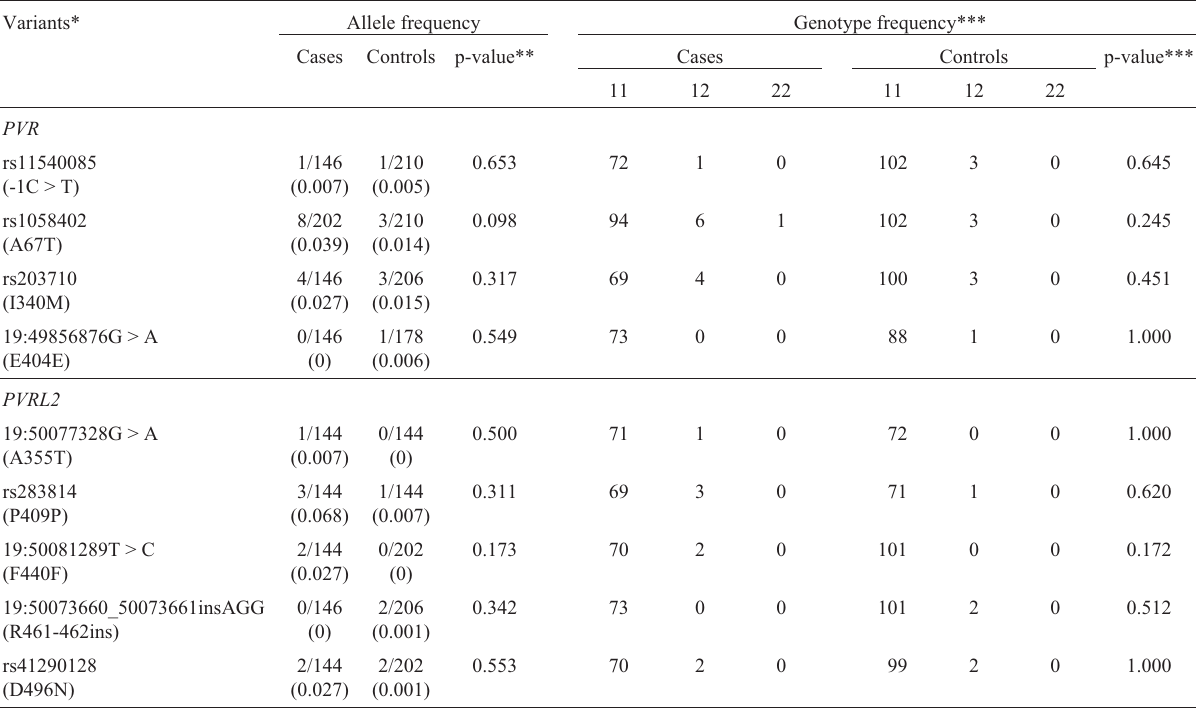
Table 2 - PVR and PVRL2 variants observed in USA CEU nsCLP patients and